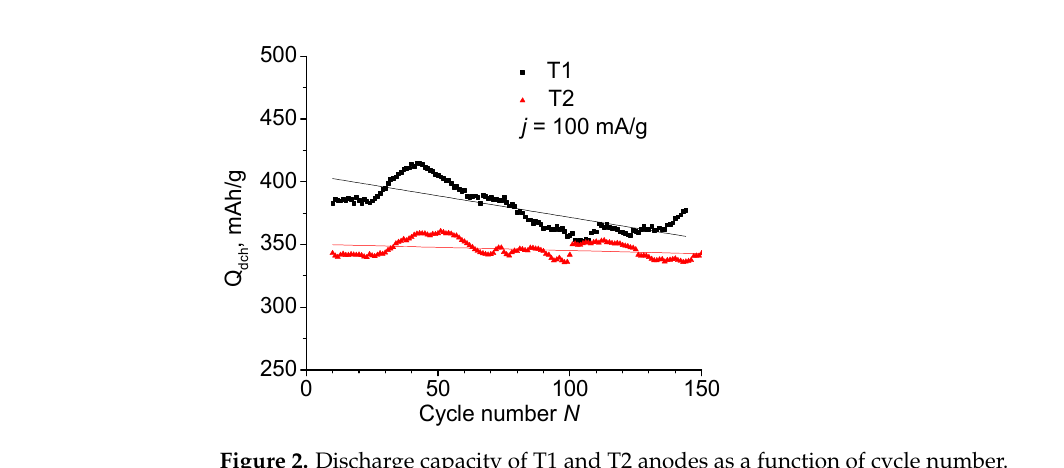
Figure 1. Charge–discharge curves of the T1 and T2 anodes: ( a ) first and ( b ) second cycle, recorded at j = 30 mA/g.